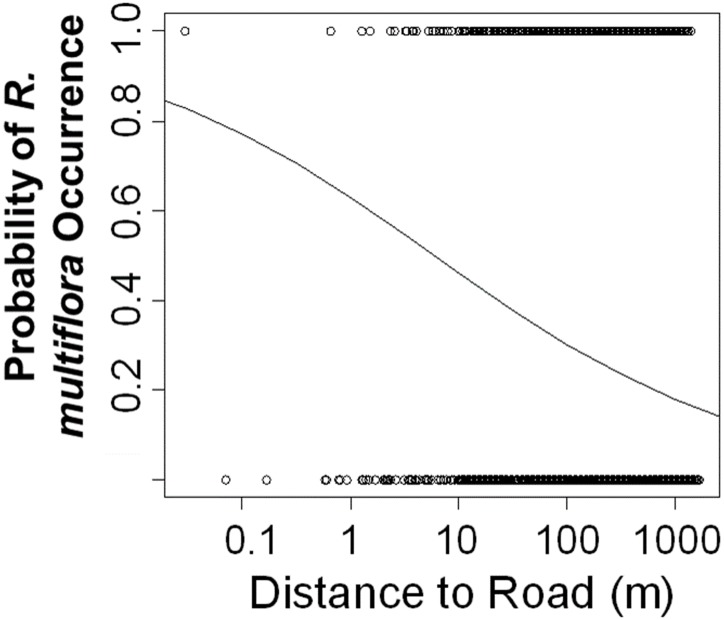
Probability of occurrence of R. multiflora versus distance to a road.Individual points represent plot-level observations of R. multiflora’s occurrence (1 = present, 0 = not present,n = 4388 plots). The best fit line was fitted using the generalized linear model of occurrence versus log distance to road and provides the probability of R. multiflora occurrence at varying distances from roadways.